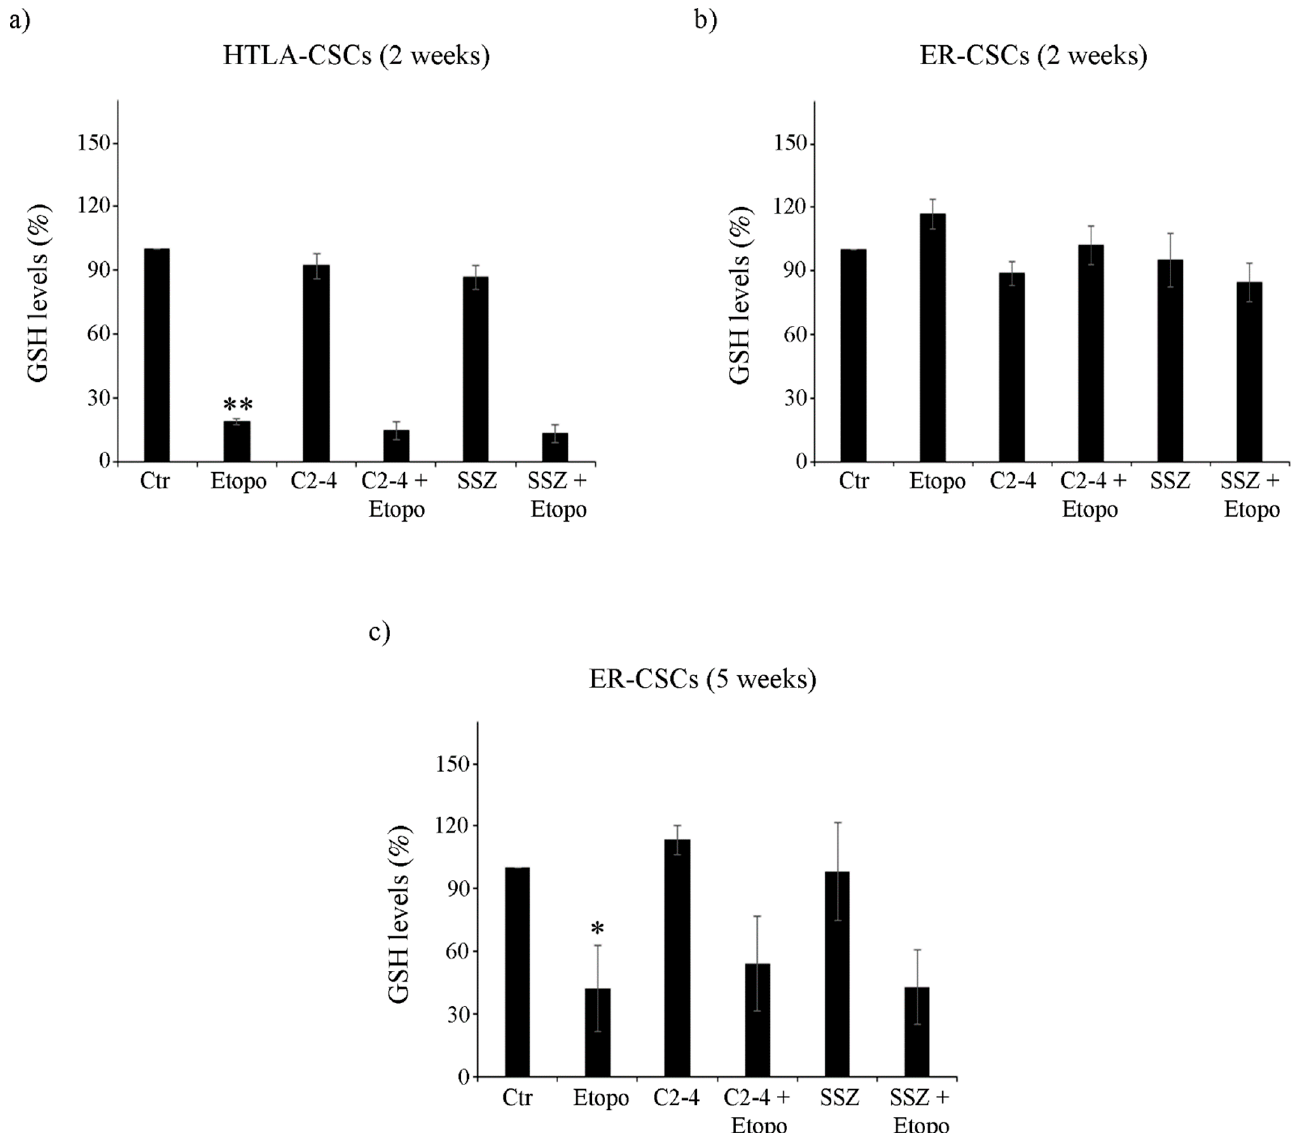
Figure 3. Glutathione (GSH) levels in both CSC populations treated for two ( a , b ) or five weeks ( c ). HTLA-CSCs and ER-CSCs were treated three times a week with 0.1 µM C2-4, with 5 µM SSZ or with 1.25 µM Etoposide, administered once a week alone or in combination with C2-4 or SSZ. GSH concentrations were determined by HPLC analysis and expressed as percentages of the control value. * p < 0.05 vs. untreated CSCs (Ctr); ** p < 0.01 vs. untreated CSCs (Ctr).